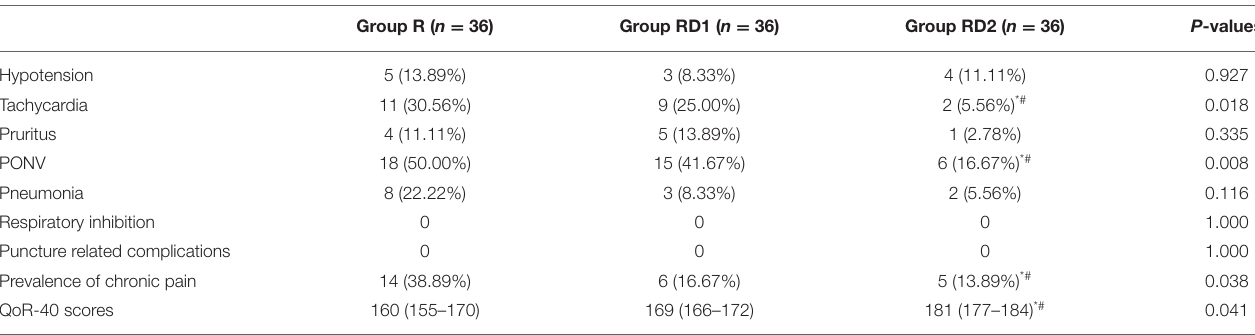
TABLE 4 | Adverse effects and post-operative